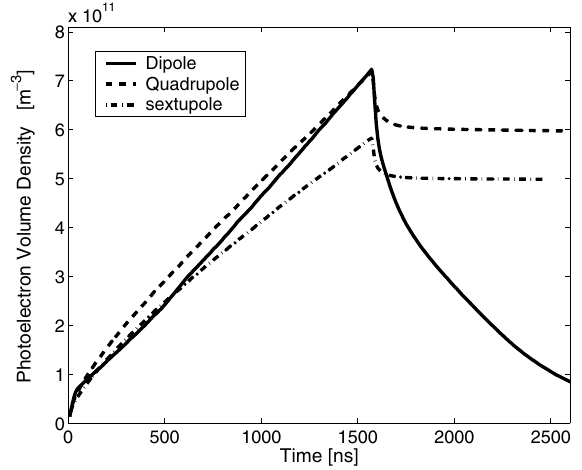
FIG. 12. Photoelectron average volume density in different magnetic fields as a function of time for a train with 200 bunches spaced by 7.86 ns and followed by a long gap.